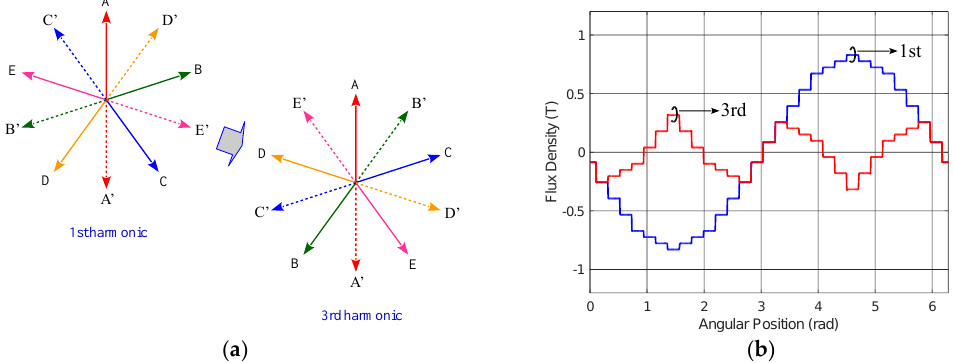
Figure 9. ( a ) Stator phases re-assembling, ( b ) mmf for the fundamental and the 3rd harmonics.